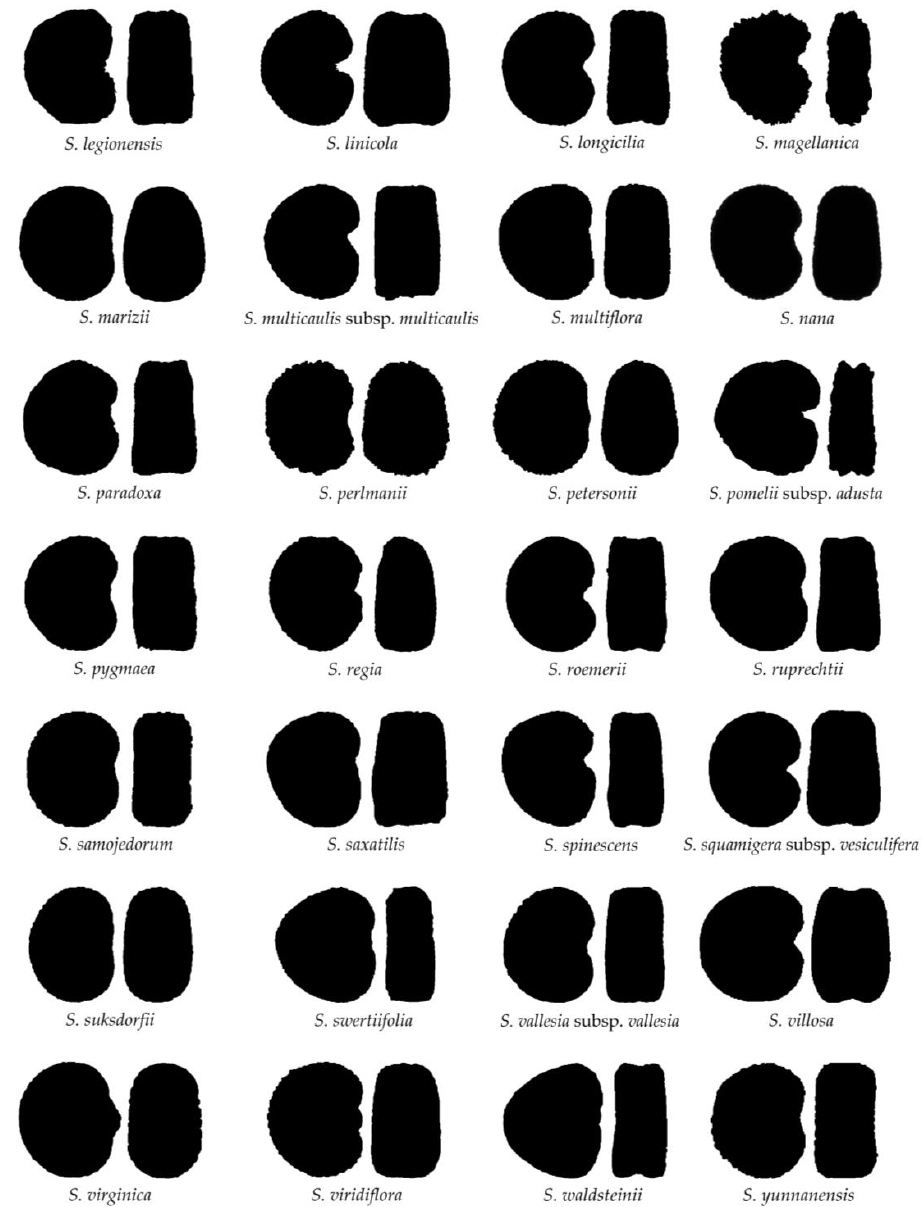
Figure A1. Average silhouettes for the species of Silene and Eudianthe, the object of this work. Table A2. Values of J index for the average silhouettes of each species with the eight lateral models: species giving higher values in models LM2, LM4, or LM8 than in other models. In bold: species that did not reach the threshold value of 89.0 for the J index estimated as the mean of 20 seeds. B: corresponds to S . subg. Behenantha ; S: corresponds to S . subg. Silene